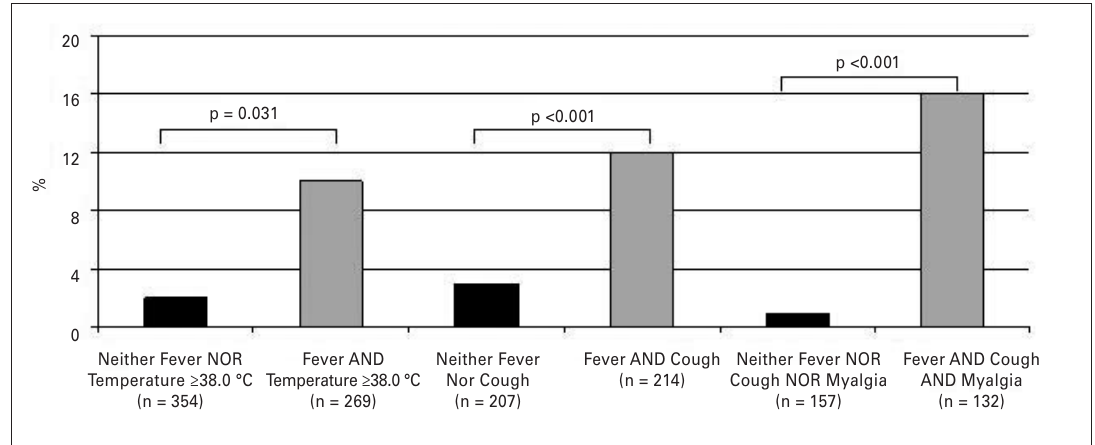
Figure 1 Symptoms and prediction of A/